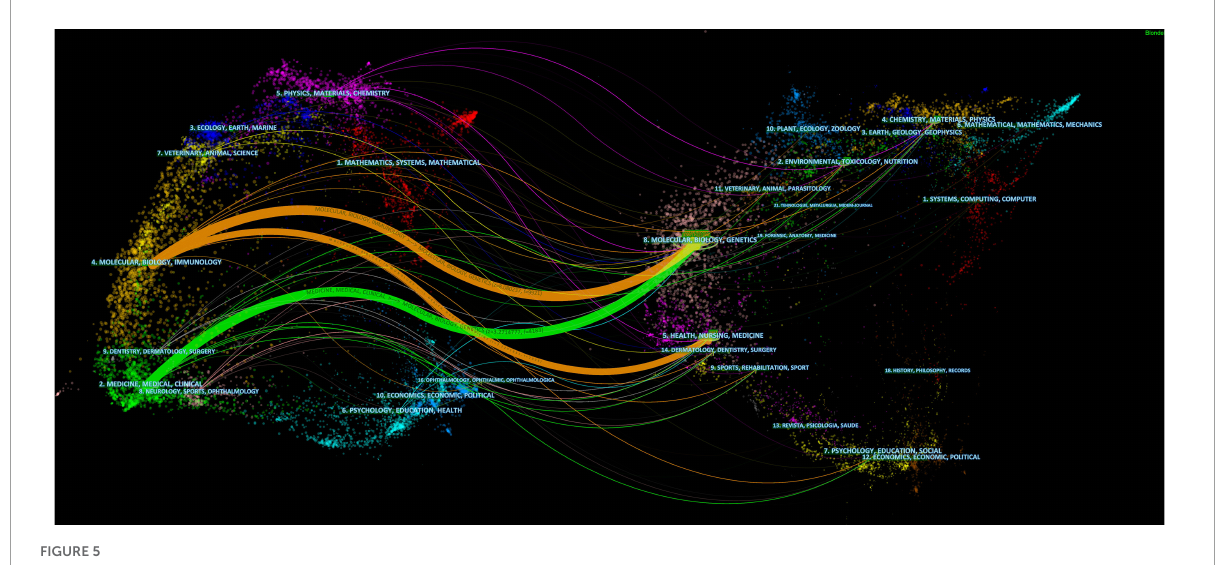
FIGURE5 CiteSpace-based dual-map overlay of journals with exosomes in